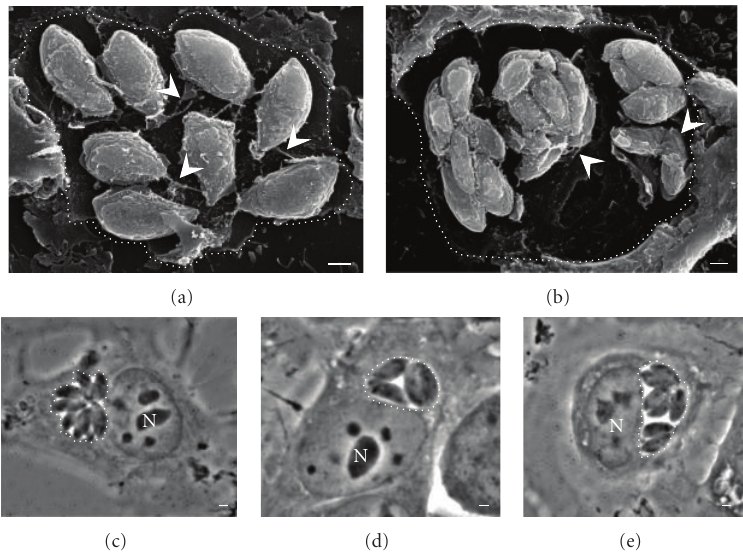
Figure 7: Absence of the GRA2 protein results in asynchrony of proliferation with loss of MNN, RB, and intravacuolar parasite cohesion. SEM-Tanaka micrographs of MDCK cells, infected by Δ GRA2 mutants for 24 h, show loss of interparasite cohesion with presence of isolated parasite aggregates within the same PV (a, b). Arrowheads indicate membranous fibers cross-linking parasites and parasites connected to the PVM. Phase contrast micrographs of live MDCK cells infected with (c) RH Toxoplasma strain or (d, e) Δ GRA2 parasites. Dotted lines were drawn to delimit the PVs. Bars = 1 µ